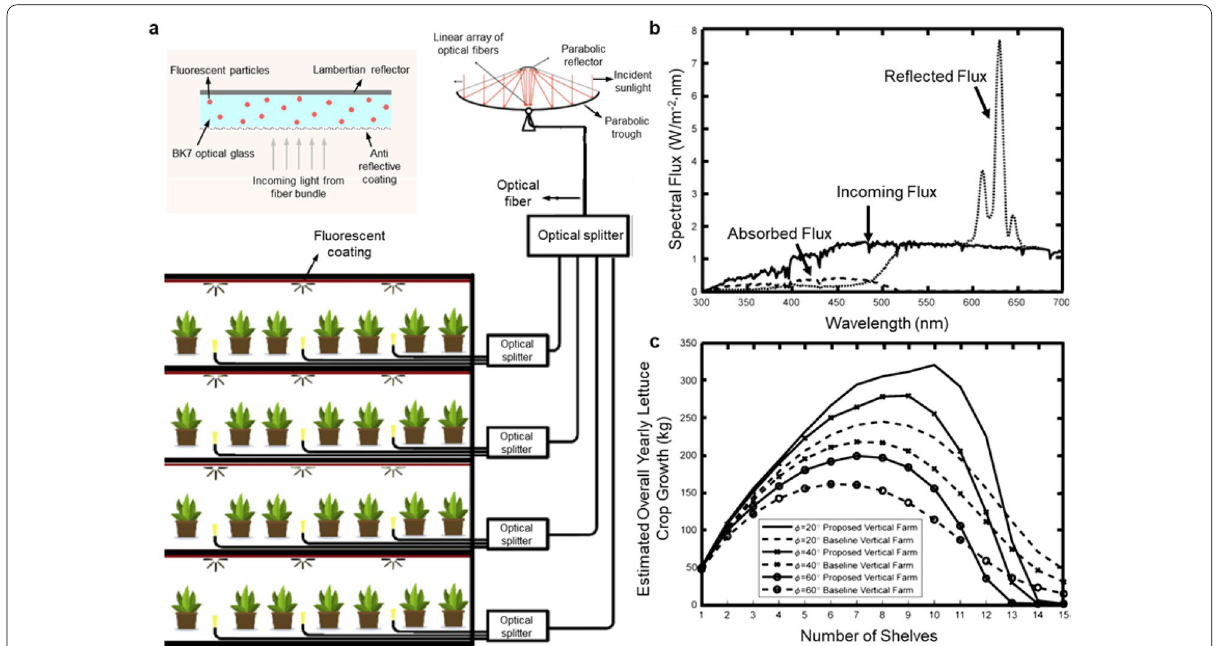
Fig. 5 a Layout of a vertical farm with a spectral conversion reflector which consists of an optical glass embedded with fluorescent pigments to convert blue-green light to red. b Spectral heat flux and reflectance of the coating. c Estimated overall yearly lettuce crop growth per greenhouse unit for different shelves number and latitudes, with and without the fluorescent reflector (based on simulations). Republished with permission from